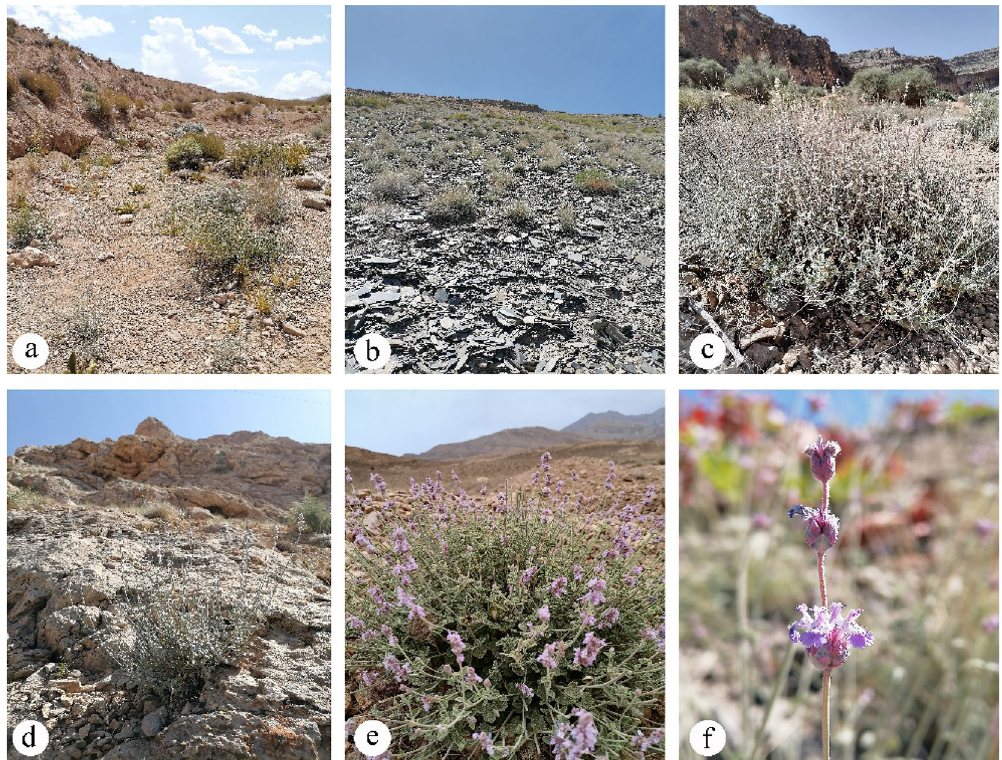
Figure 2. Nepeta glomerulosa : ( a – d ) Habitats. ( e – f ) life form and morphology of flower specifically, photos show ( a ) dry river bed, ( b ) gravelly slopes, ( c ) Amygdalus community, ( d ) dry rocky slopes, ( e ) life form, and ( f ) morphology of